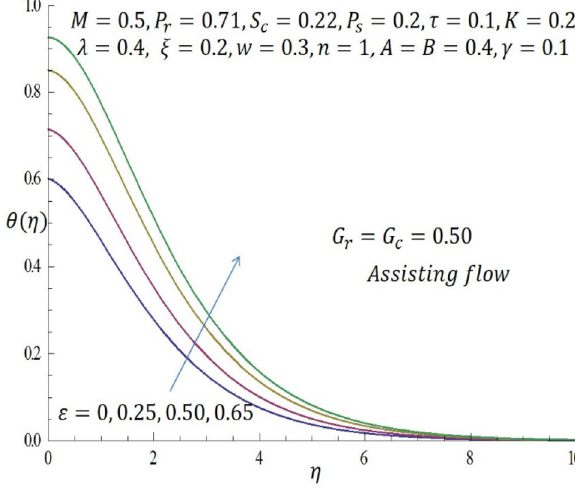
Figure 10. Effect of ε on temperature profile when G r = G c = 0.5.